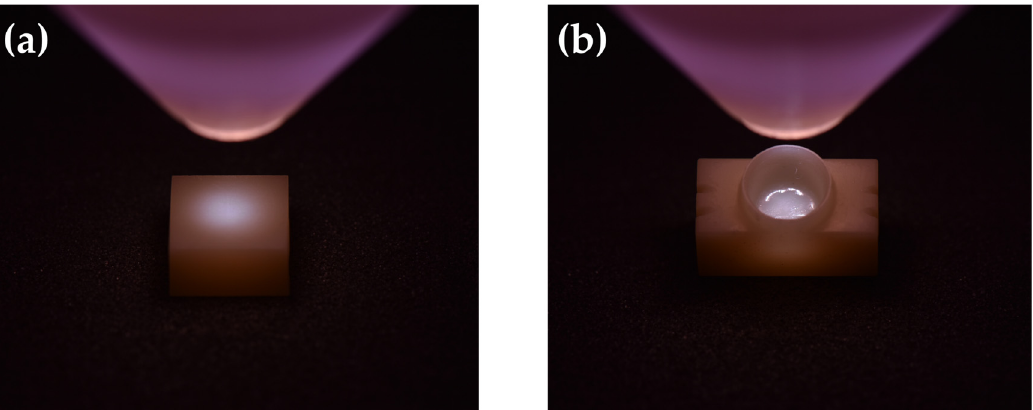
Figure 4. ( a ) Non-thermal atmospheric pressure plasma (NTP) treatment on the cube-shaped zirconia block. ( b ) NTP treatment on the inner surface of the zirconia crown.